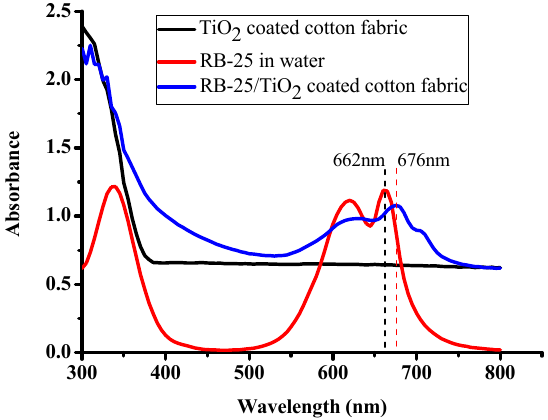
Figure 4. UV ‐ Visible absorption spectra of RB ‐ 25 in water, TiO 2 ‐ coated cotton fabric and RB ‐ 25/TiO 2 ‐ coated cotton fabric.